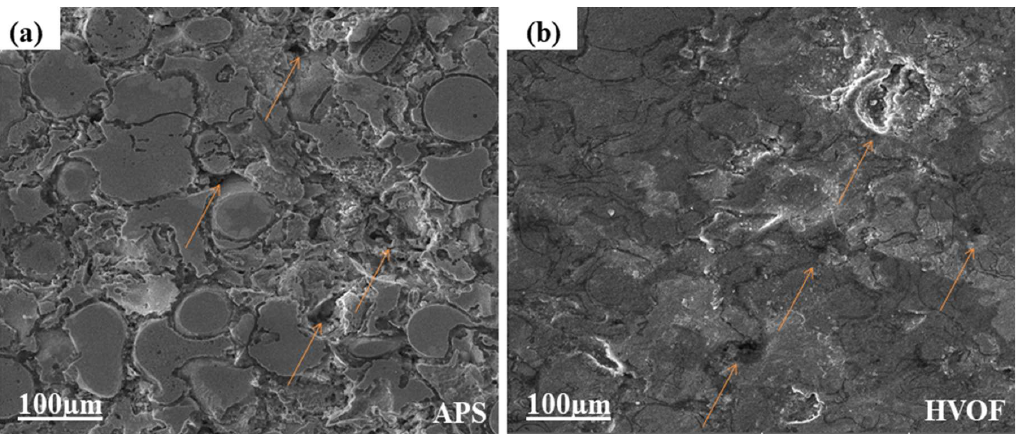
Figure 4. SEM images showing the morphology of APS ( a ) and HVOF coating ( b ) after potentiodynamic polarization. The arrowheads indicate a corroded portion on the surface.